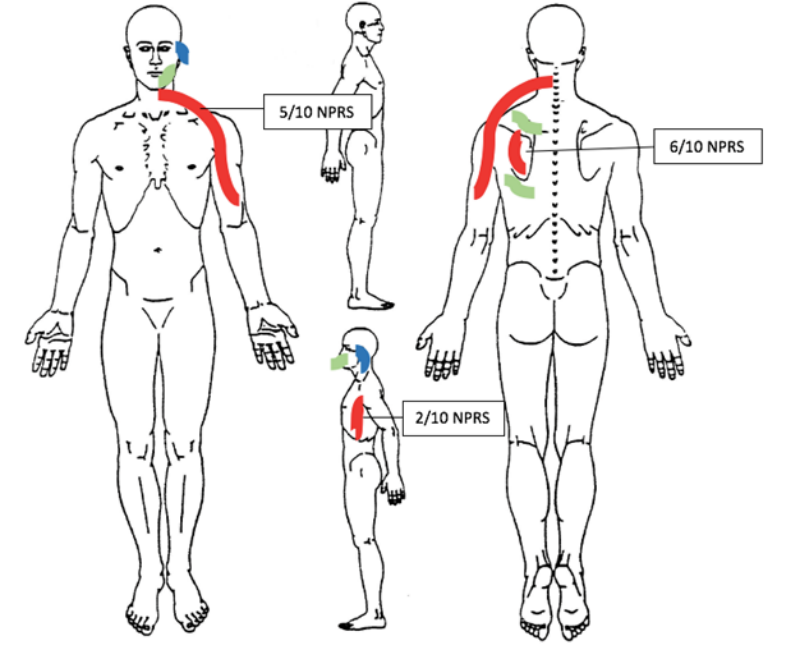
Figure 2. Body chart. Notes: Red lines indicate pain areas; green lines indicate paresthesia; blue lines indicate hearing impairment.